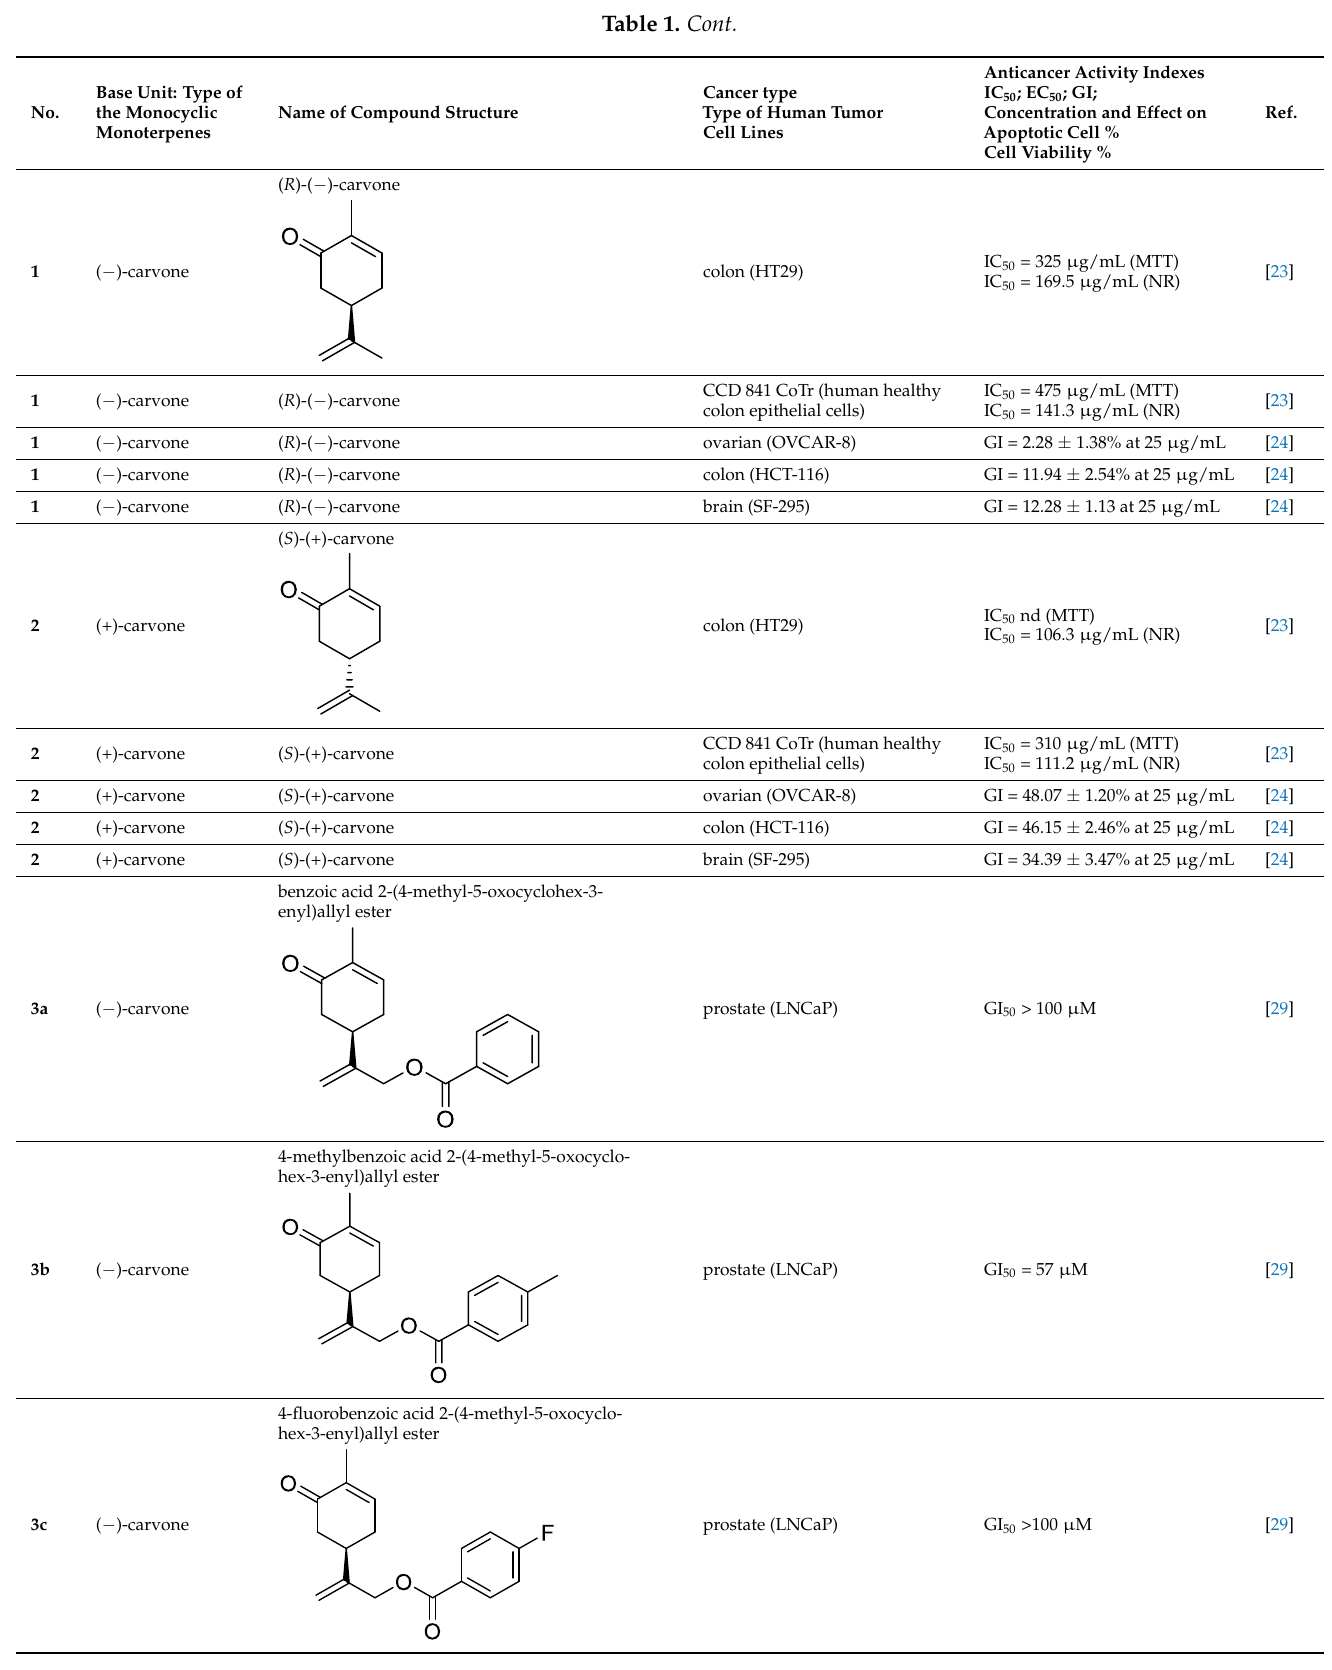
Name of Compound